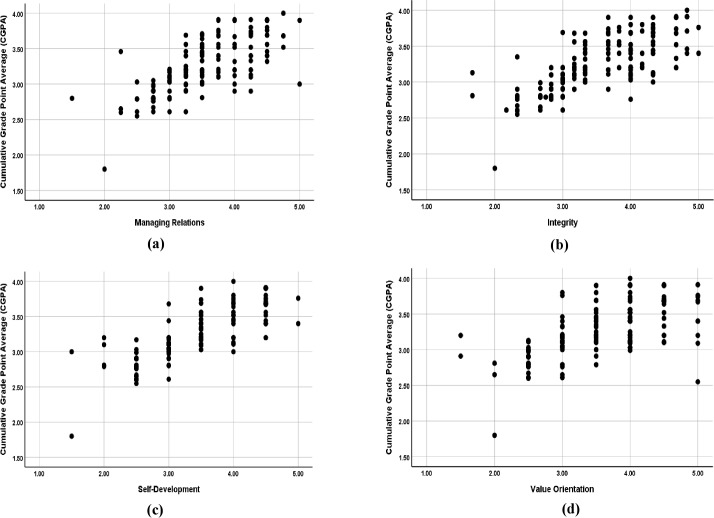
Correlation between the subdimensions of emotional intelligence and academic success.The scatterplots (a-d) plainly portray the significant positive relationship among Managing Relations & CGPA; Integrity & CGPA; Self-Development & CGPA; and Value Orientation & CGPA.